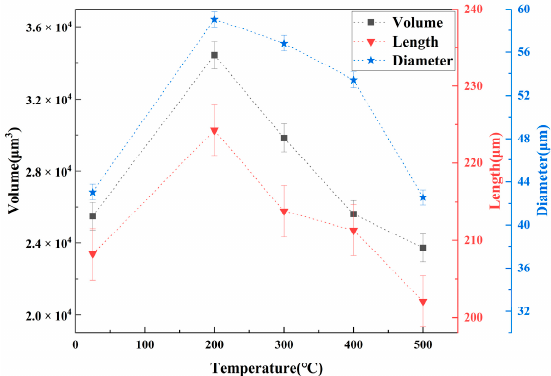
Figure 8. The volume, length and diameter of a long strip (Type Ⅱ ) pore as a function of the temper- ature.